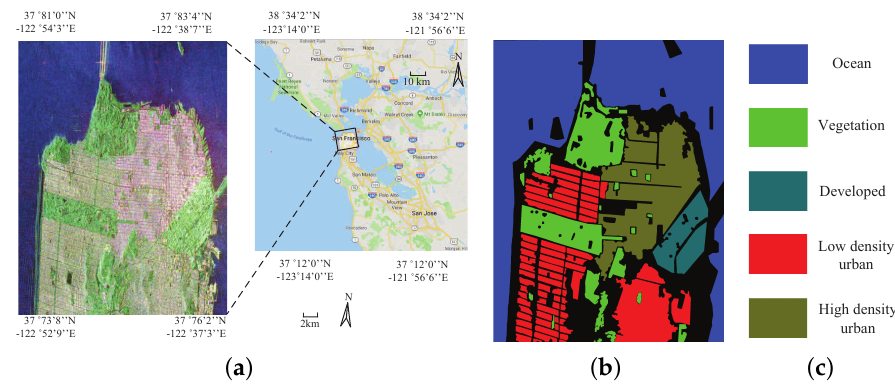
Figure 5. San Francisco. ( a ) Left: PauliRGB image with its coordinate, right: the photo of near area with its coordinate, which is from Google Maps. ( b ) Ground truth map. ( c ) Color code.